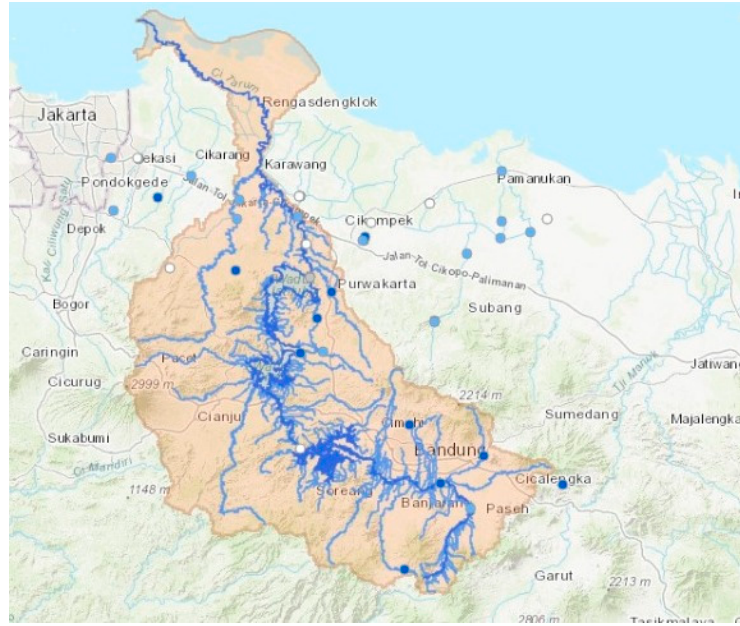
Figure 2. Citarum River map with its watershed boundary [37].